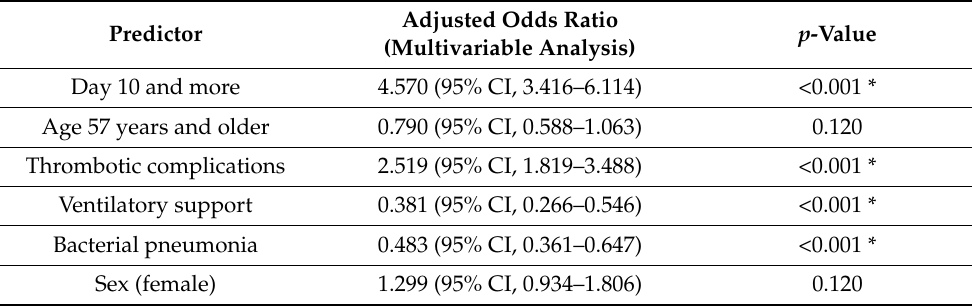
Table 5. Multivariable regression analysis: independent predictors of increased mean optical density (above 0.46) in arterial endothelium (with adjusted odds ratio